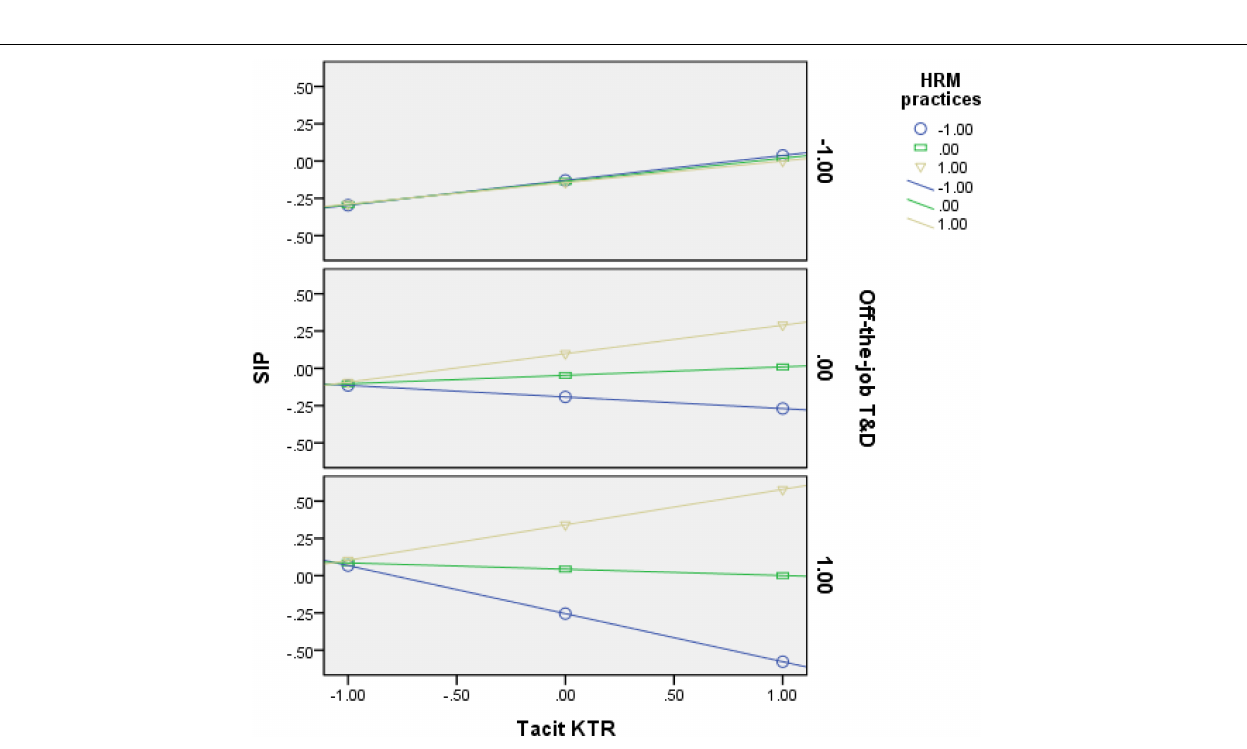
Frontiers in Psychology |